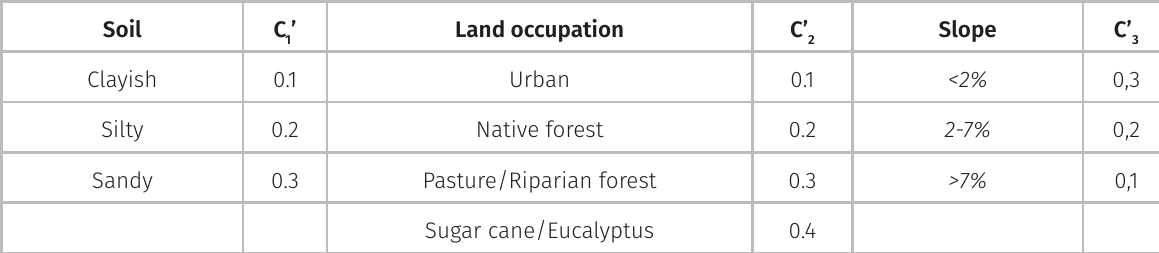
Table I. Parameters for calculating surface runoff.